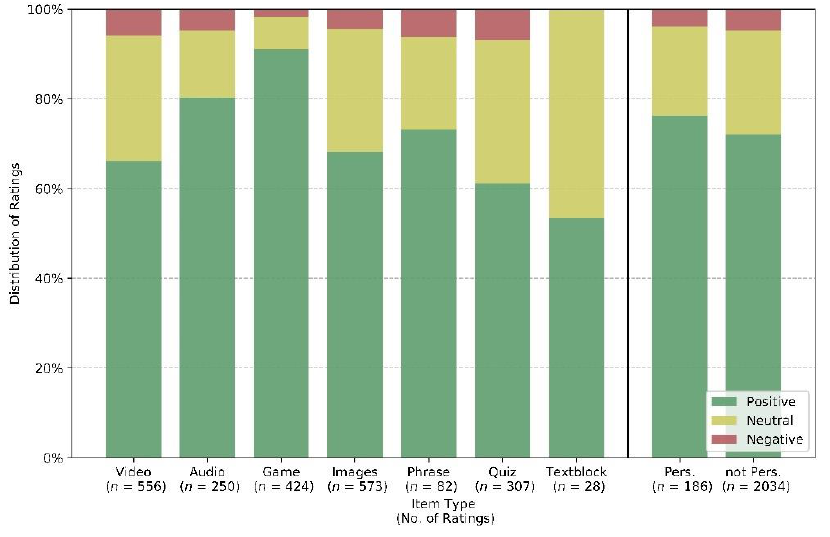
Figure 7. All types of content get mostly positive assessments, with games and audio achieving best marks on average.